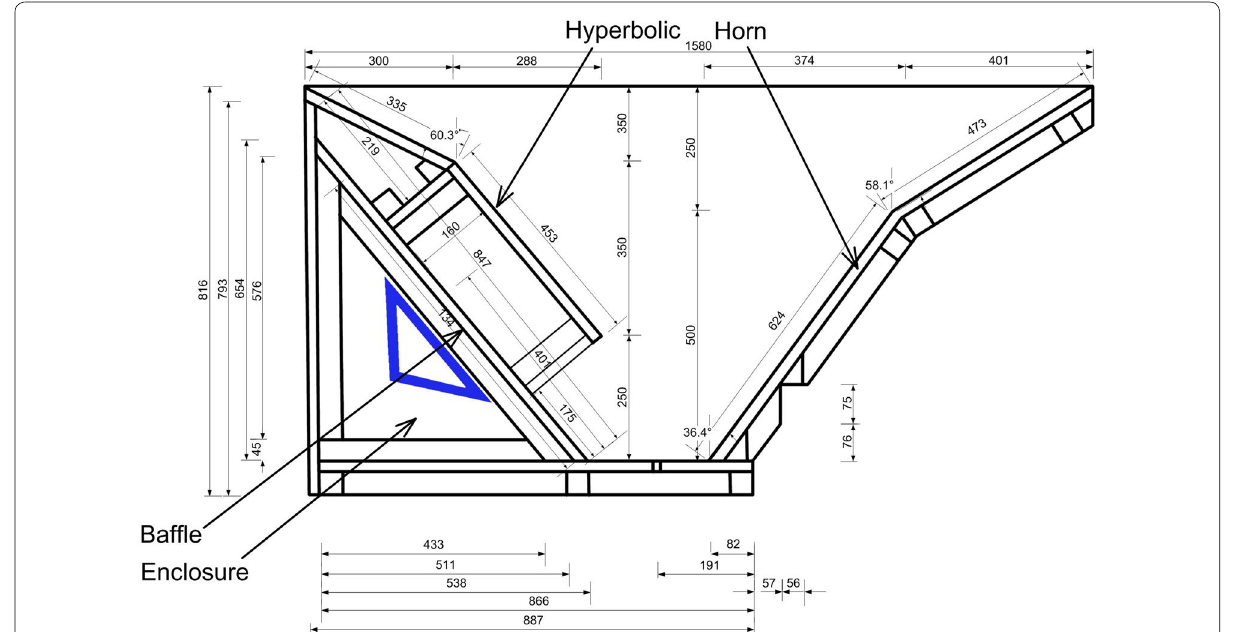
Fig. 4 Cross section of the horn speaker (Adachi 1996). A blue triangle indicates a woofer speaker that is commercially